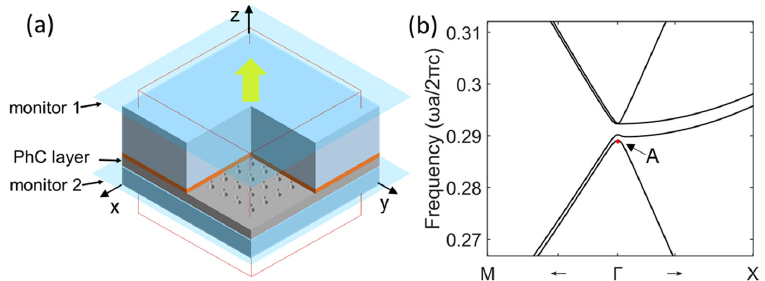
Figure 1. ( a ) Schematic of the photonic-crystal surface-emitting laser (PCSEL) model adopted in the simulation. The orange layer represents active layer, below which is the photonic crystal (PhC) layer. The top and bottom layers are cladding layers. The translucent blue planes represent field monitors. The red box represents simulation region. The yellow arrow represents light emission direction. ( b ) The typical photonic band of the square-lattice PCSEL near Γ 2 point. Point A is the band edge where PCSELs commonly work at.